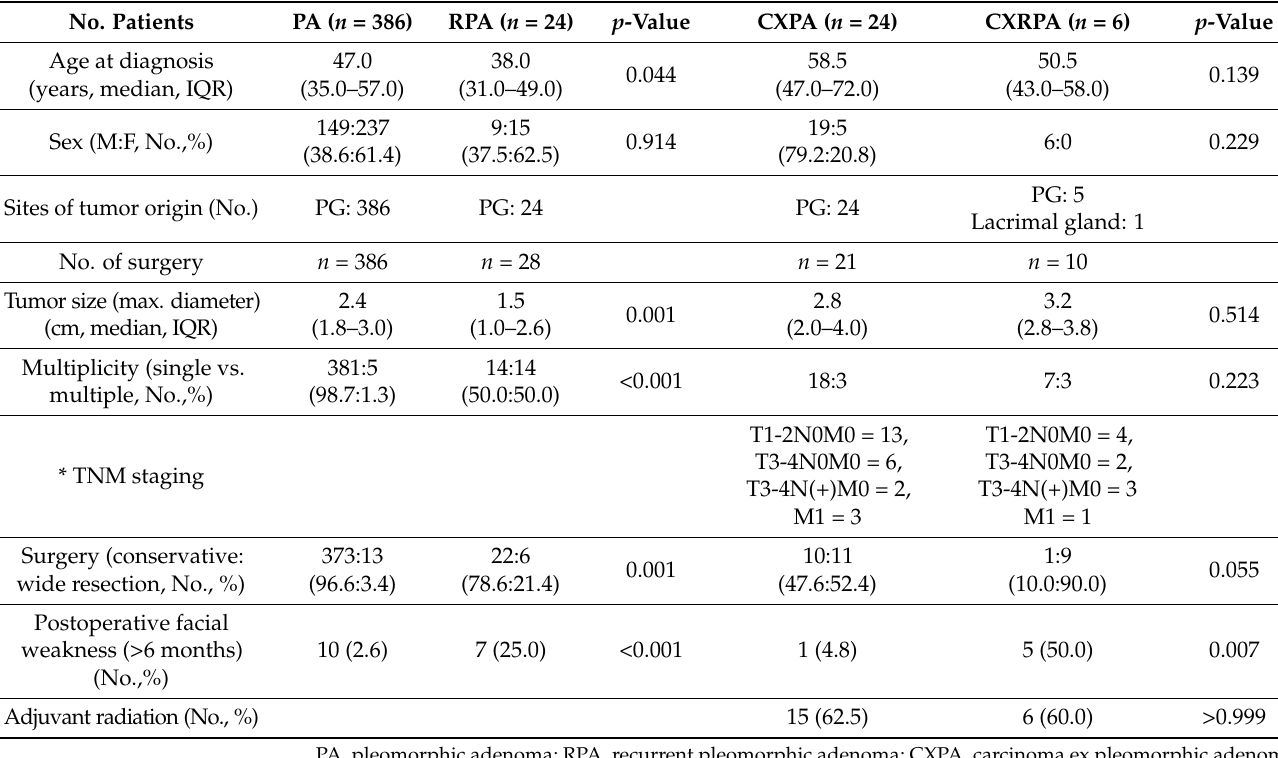
Table 1. Subject